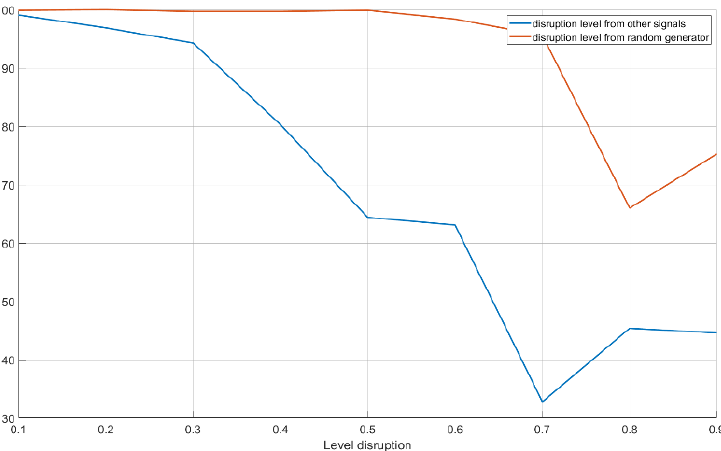
Figure 17. Effectiveness of signal recognition depending on the level of signal